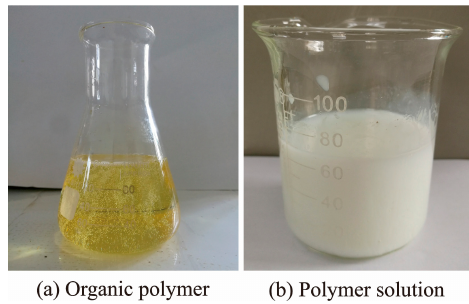
Figure 2. Photo of ( a ) Organic polymer; and ( b ) Polymer solution.